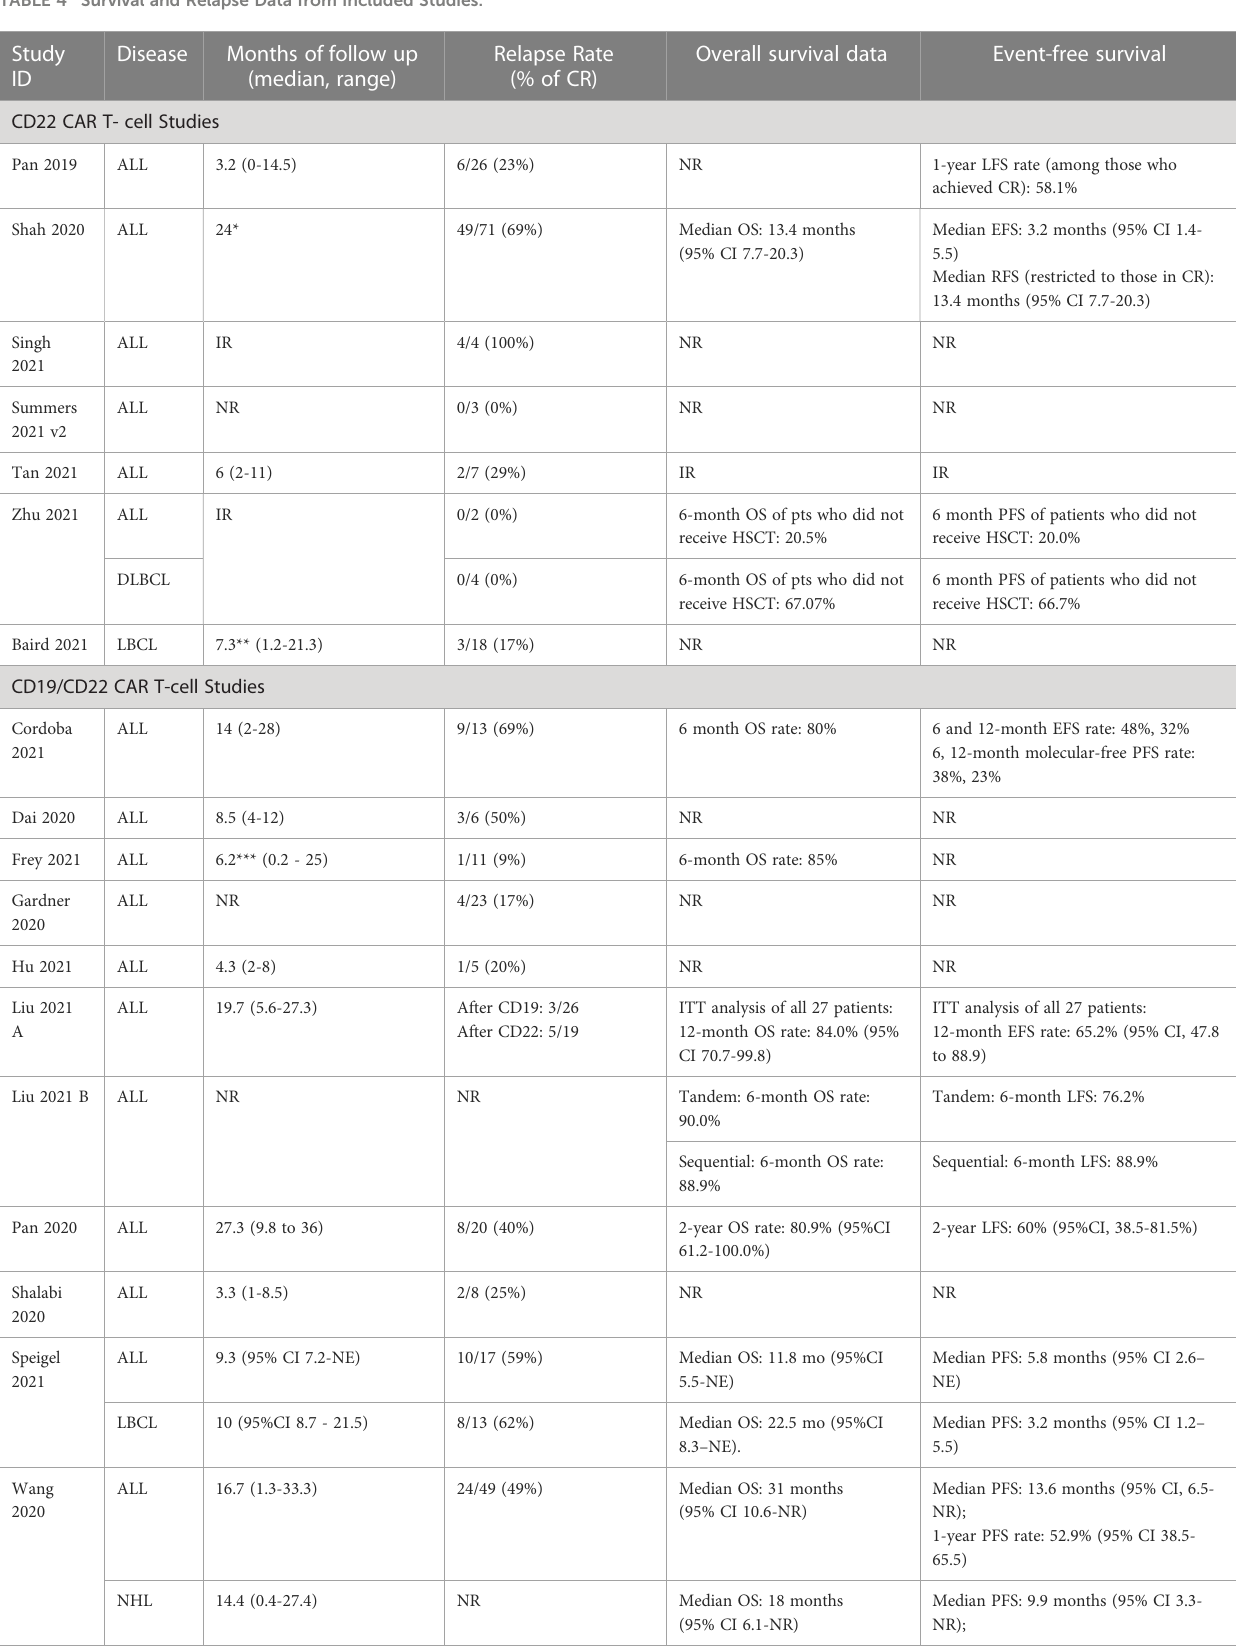
TABLE 4 Survival and Relapse Data from Included Studies. Study ID